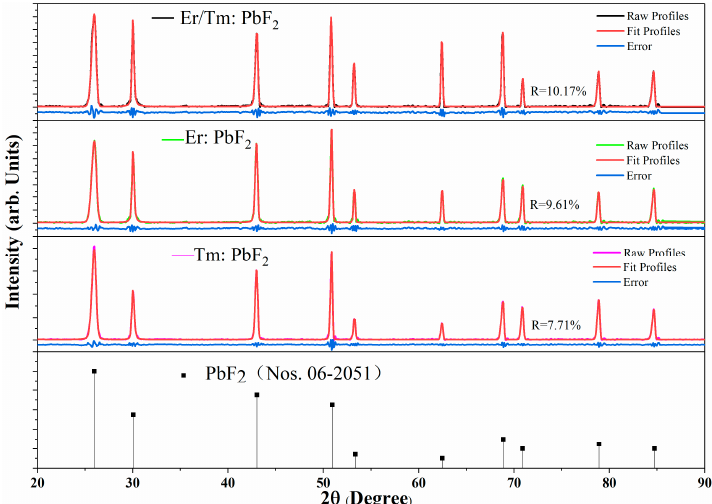
Figure 1. XRD patterns and refined XRD patterns of the Er/Tm: PbF 2 , Er: PbF 2 , Tm: PbF 2 crystals and PbF 2 crystal standard